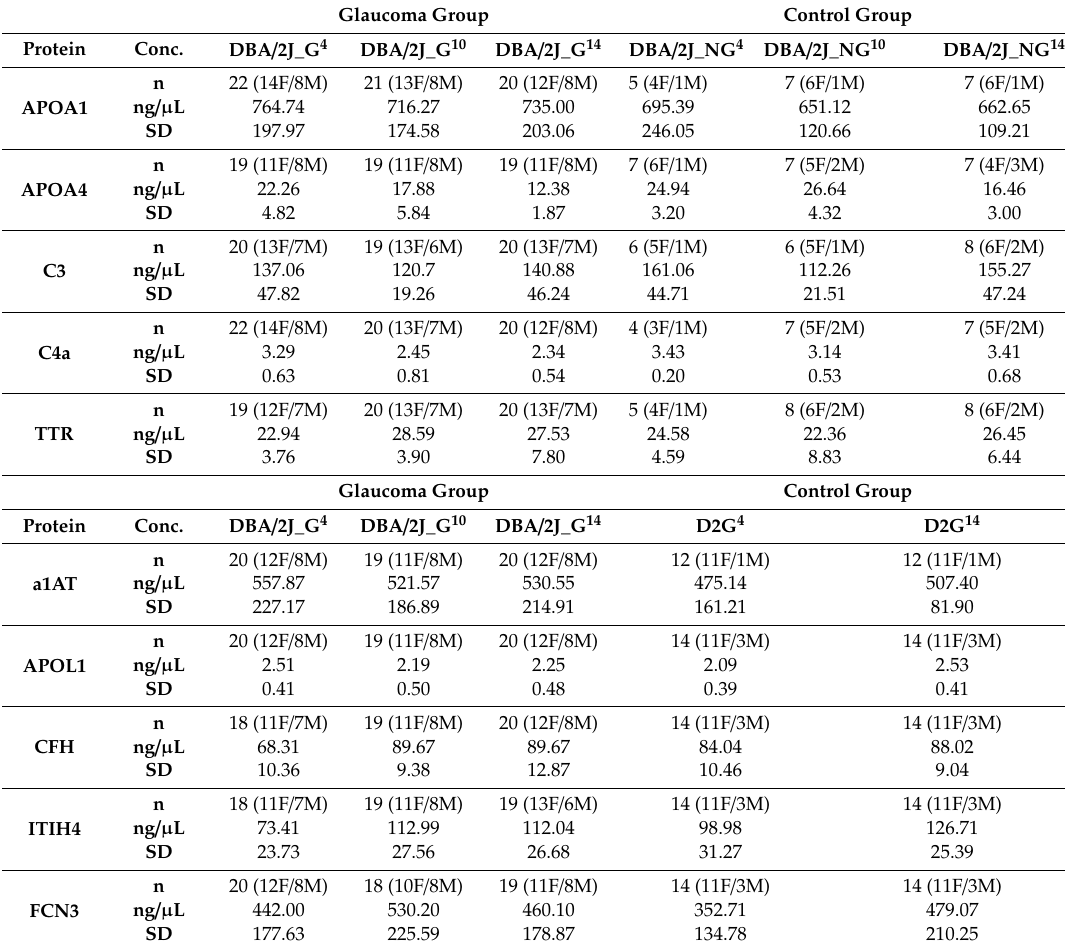
Table 1. Concentrations of proteins (ng / µ L) obtained by ELISA analysis in serum of glaucoma and control groups.